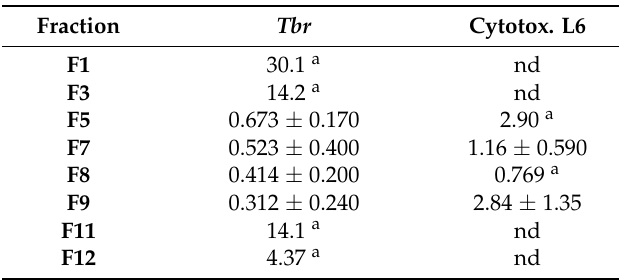
Table 2. In vitro and cytotoxic activity (IC 50 values in µ g/mL) of selected fractions of the DCM extract from V. lasiopus. For positive controls, see Table